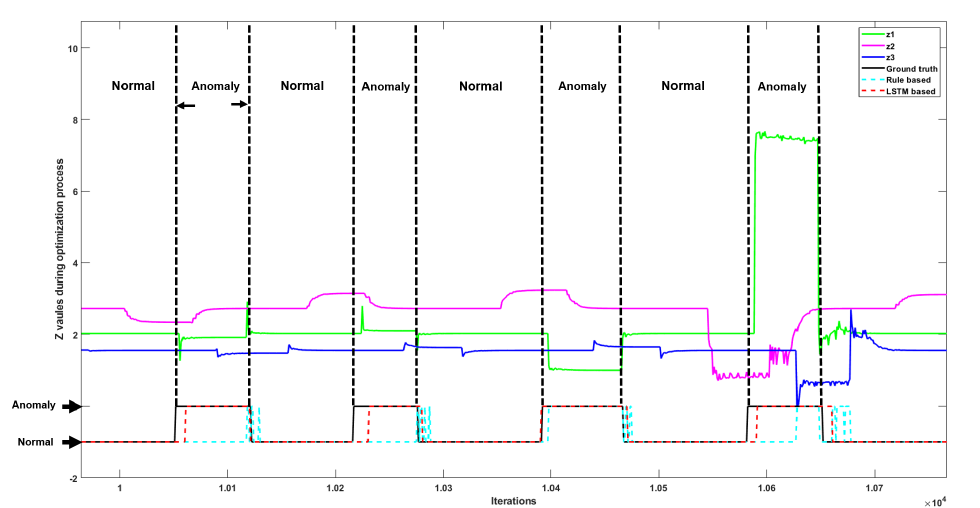
Figure 8. The z values of devices 1, 2, and 3 in the RS, including both normal and abnormal situations. General two-class detection results from the rule-based method (turquoise dotted line) and LSTM (red dotted line) are compared with the ground truth (black